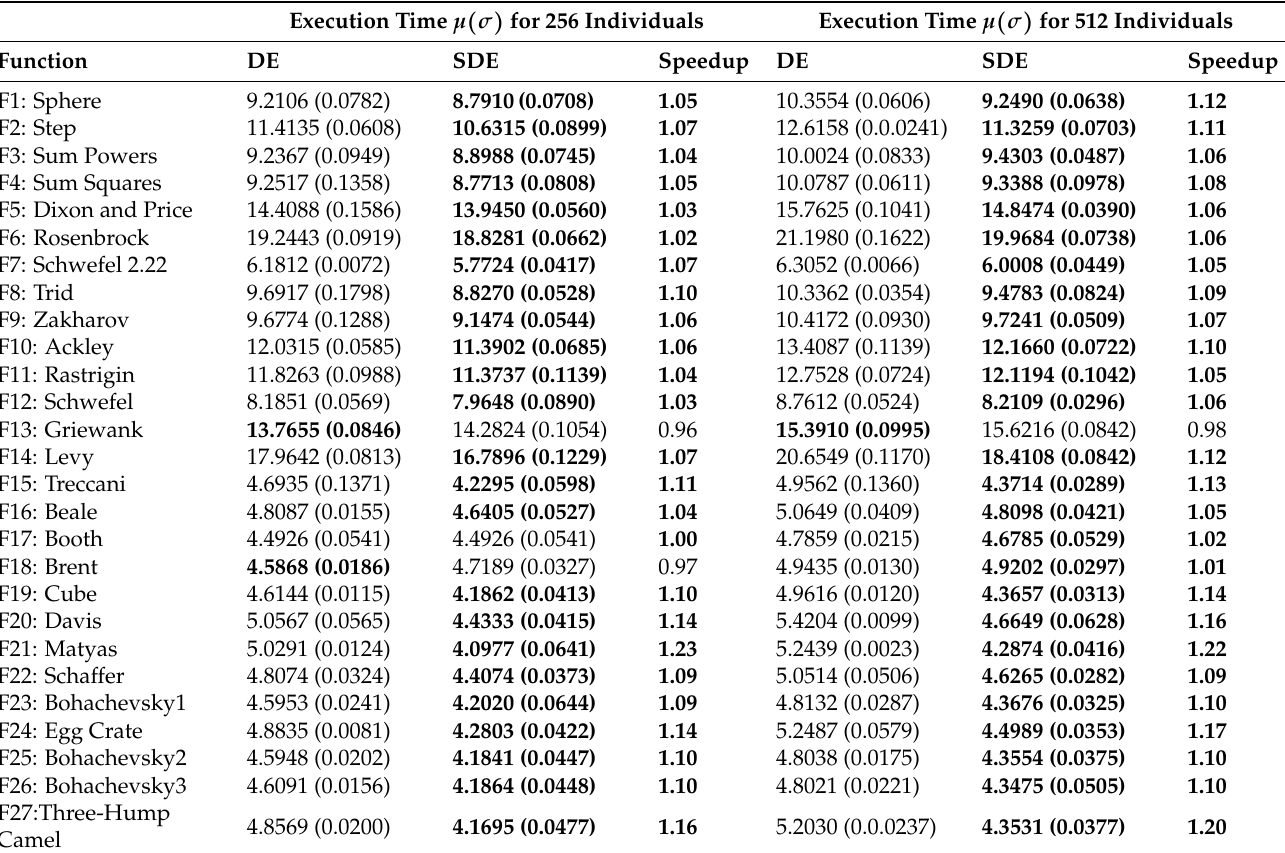
Table 5. Mean and averaged execution times in seconds of DE and SDE ( D = 100).